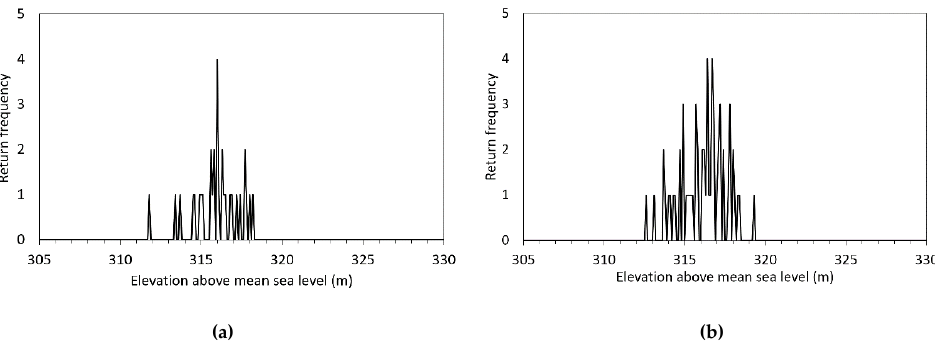
Figure 6. ICESat GLAS east region returns ( a ) GLAH06, ( b ) GLAH14.